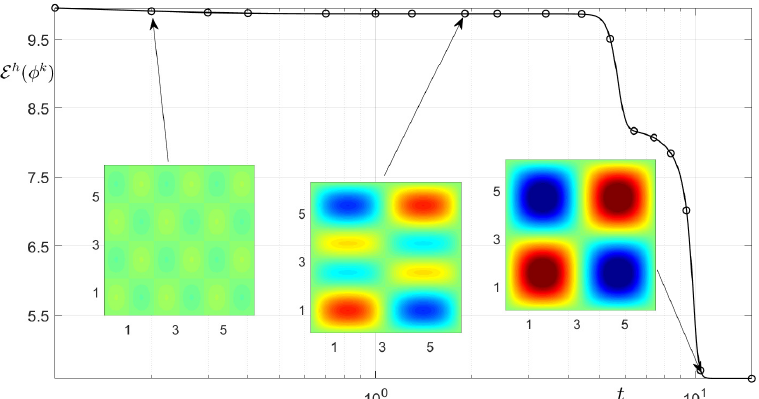
Figure 20. Energy decay over time to the MBE model. Note that t -axis is on log-scale.